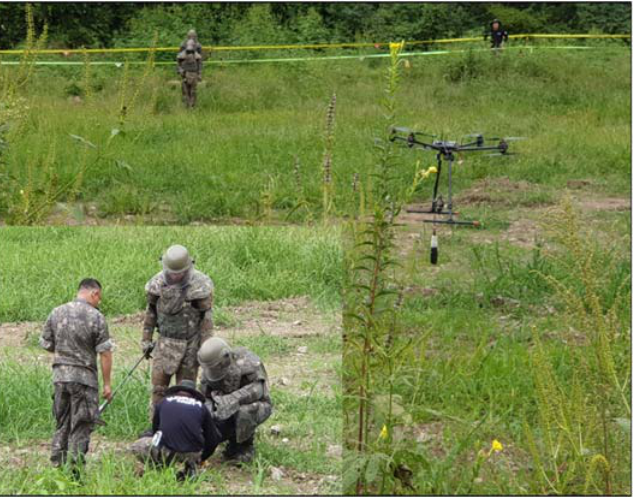
Figure 9. Explosive ordnance disposal (EOD) team operations and abnormal object.